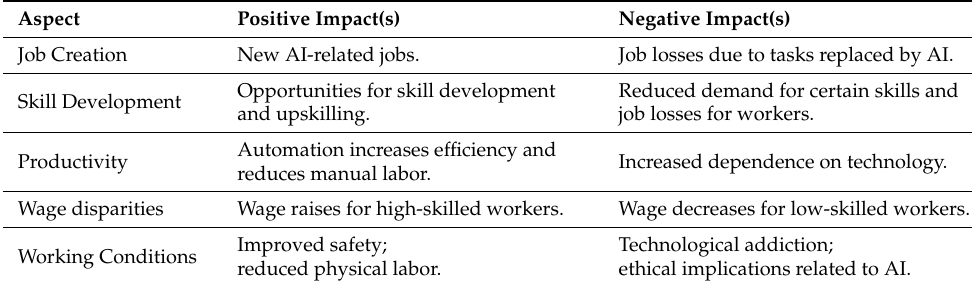
Table 8. The positive and negative impacts of AI, operating as a disruptive tool, on the labor market.